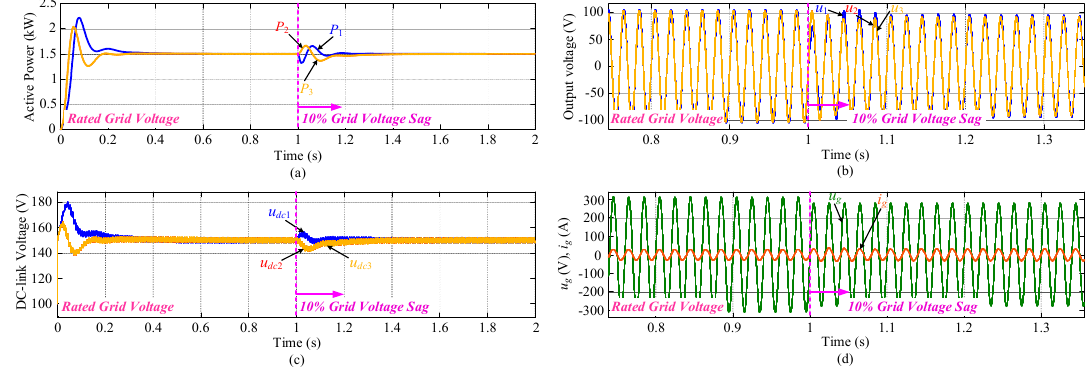
Figure 7. Simulation results under 10% grid voltage sag condition. ( a ) Active power; ( b ) Steady-state output voltages; ( c ) DC-link voltages; ( d ) Grid voltage and line current in steady state.